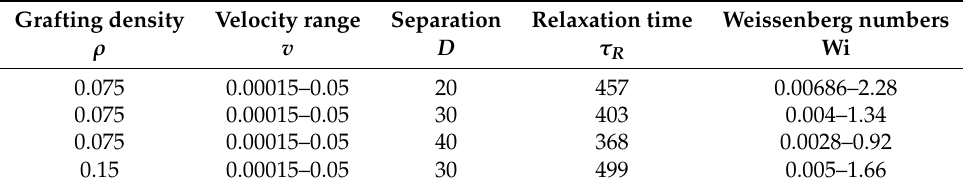
Table 2. Same as Table 1 for the velocity-dependency studies.